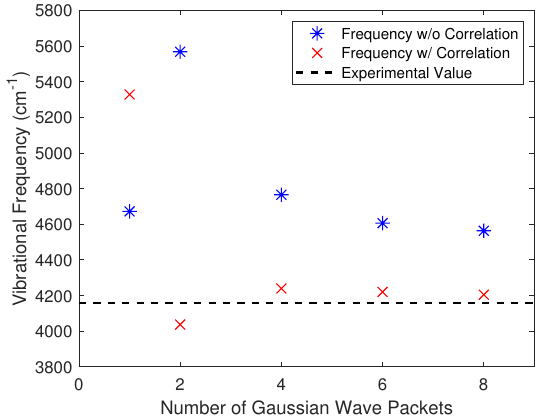
Figure 4. Vibrational frequency of the H 2 molecule with an increasing Gaussian basis set. Blue stars are the frequencies with no VB correction. Red crosses are the frequencies calculated with the VB correction ( ρ = 1). The black dotted line represents the experimental value of the fundamental frequency of H 2 . In each case the fundamental frequency was calculated by displacing two H ions by 0.01 Bohr and observing the resulting